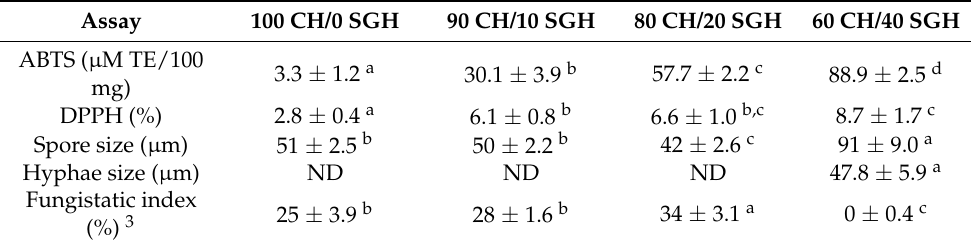
Table 4. Antioxidant activity 1 and fungistatic activity 2 of chitosan (CH) with squid gelatin hy- drolysate (SGH) films.